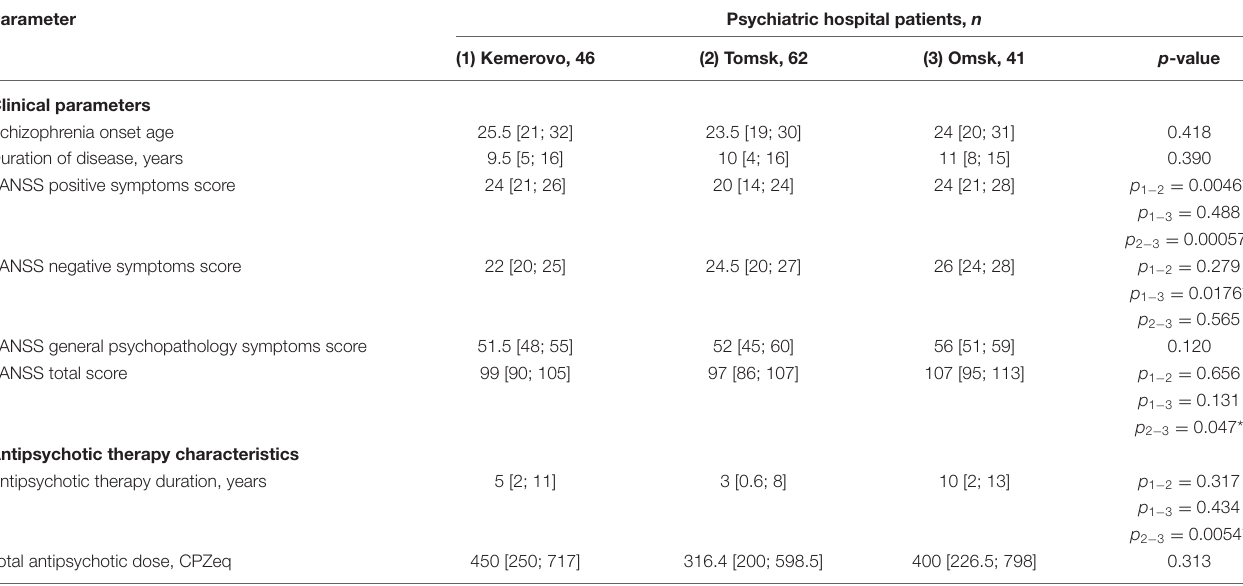
TABLE 5 | Comparative characteristics and evaluation of clinical parameters and antipsychotic therapy in the female part of the study population (Me [Q1; Q3]).